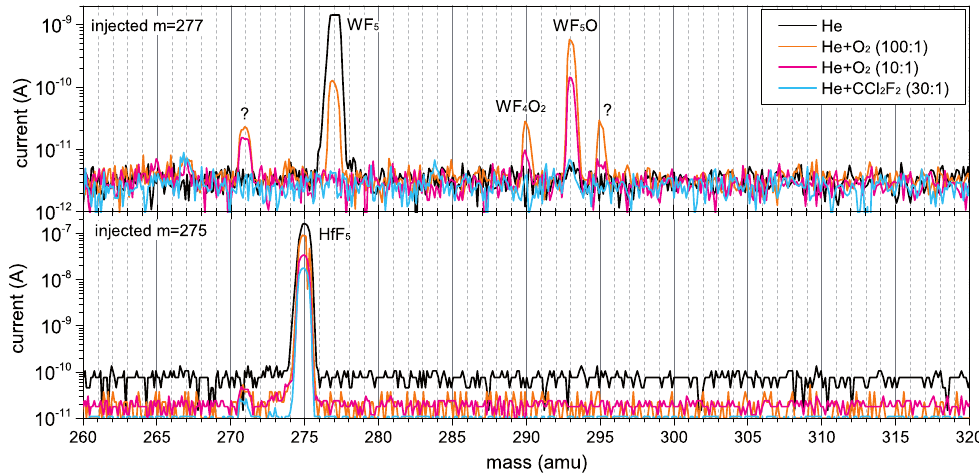
Figure 2. Mass scans of the anion beam extracted from the ILIAMS ion cooler operated with di ↵ erent bu ↵ er gases at an inlet bu ↵ er gas pressure of 0.30mbar for all scans. The top graph shows the mass spectrum when injecting 182 WF  injecting 180 HfF  (m = 275). For better mass resolution, the current was measured in the Faraday cup directly following the VERA 5 tandem accelerator. Plotted currents are thus convoluted with the charge-state distribution and do not represent primary anion beam intensities. Variations in background stem from di ↵ erent sensitivities of the current amplifier (model